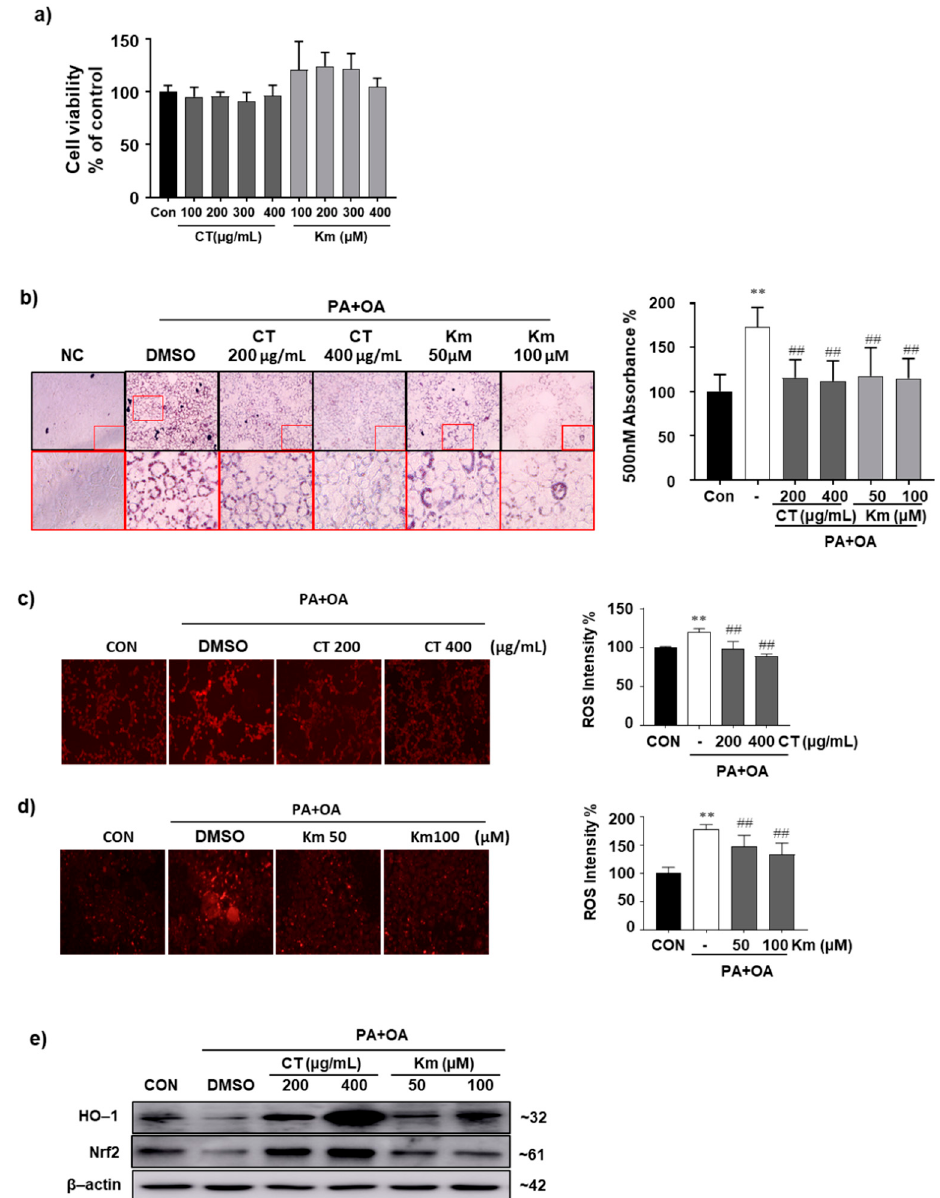
Figure 6. CT extract reduces in vitro lipid accumulation in AML-12 mice hepatocyte cells. ( a ) MTT assay was performed in AML-12 cell treated with whole CT leaf extract (100–400 µg/mL) and kaempferol (100–400 µM). ( b ) AML-12 cells were seeded, after inducing steatosis by 1mmol/L (3:1, oleic acid: palmitic acid) medium, cells were treated with 0.1% DMSO or CT extract (200 and 400 µg/mL) or kaempferol (50 and 100 µM) and performed Oil Red O staining (left) and absorbance (right) was observed at 500 nm. Intracellular ROS was estimated by dihydroethidium (DHE) staining in AML12-cell treated with ( c ) CT extract ( d ) kaempferol and bar graph was plotted for fluorescence intensities of DHE (each right side). ( e ) The expression level of heme oxigenase-1 (HO-1) and nuclear factor, erythroid 2 like 2 (Nrf2) were performed by western blotting and normalized to β -actin. The result is representative of three individual experiments. Values are mean ± SD. AVOVA p -value: ** <0.01 vs. control group; ## <0.01 vs. DMSO treated group .